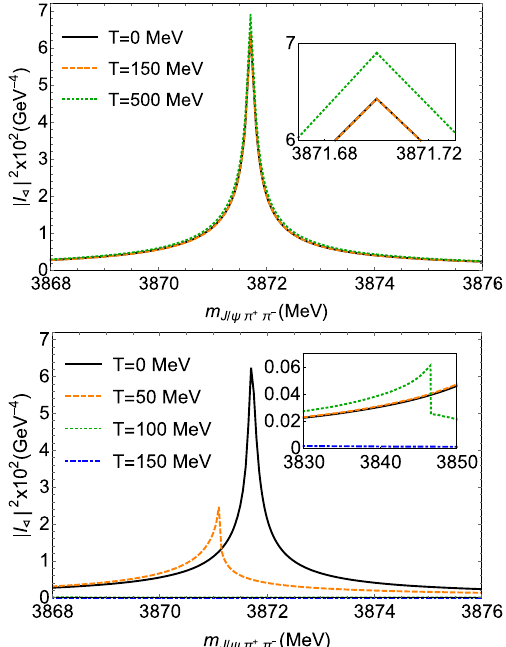
Fig. 4 Squared triangle graph ( | I (cid:4) | 2 ) in Eq. (6) against m C for c ¯ c ( A ) → ( J /ψπ + π − )( C )π − ( B ) [11]. Top: the temperature affects only the loop variable, but M i , Γ i are fixed at their vacuum values [24]. Theeffectof T isverysmall.Bottom:thermalcorrectionstothe ( 1 , 2 , 3 ) meson masses and widths included (Table 1); the singularity melts with